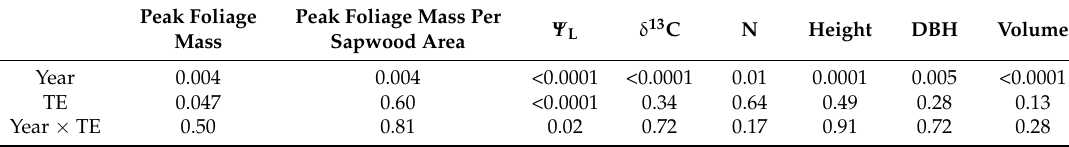
Table 2. Statistical significance for the effects of year and throughfall exclusion (TE) on peak foliage mass, peak foliage mass per unit sapwood area, stable carbon isotope ( δ 13 C), nitrogen concentration of the foliage, total height growth, total diameter at breast height (DBH) growth, and total volume growth for the measurement period